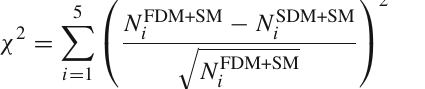
Table4 Thetotalproductioncrosssection( σ 0 ),crosssectionafterpre- selection ( (cid:18) pre ) and number of signal ( N S ) at the ILC with